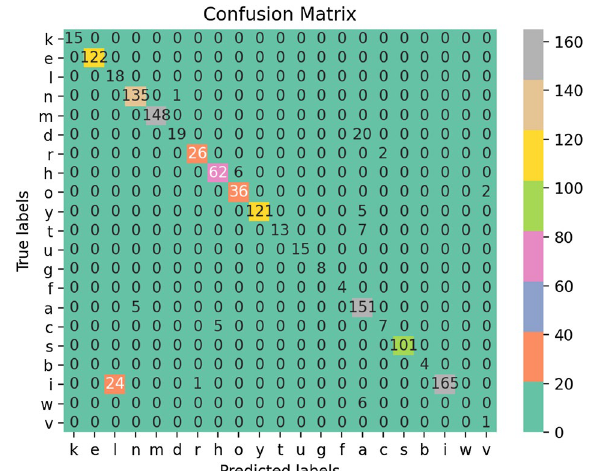
Fig. 14 Greeting sentence confusion matrix